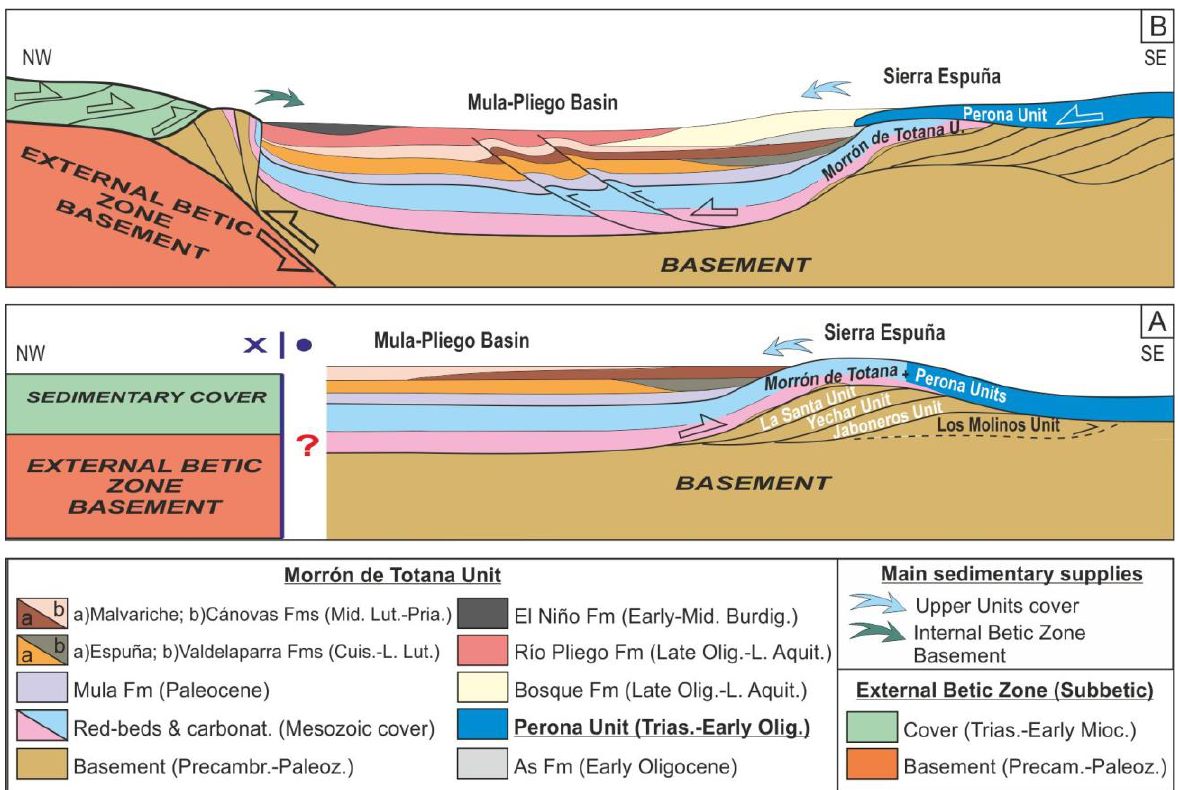
Figure 3. Interpretative tectono-sedimentary cross-sections of the Malaguide Basin from Sierra Espuña (modified from [1]). ( A ) Preorogenic Cycle (Paleocene-Earliest Oligocene). ( B ) Syn-orogenic Cycle (Late Oligocene-Early Miocene).